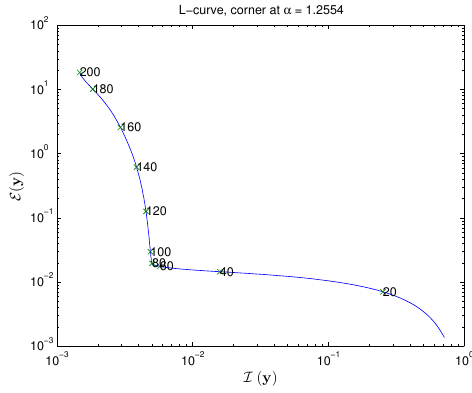
Figure 2. L-curve corresponding to the minimization of J α ( y ) with determination of all the coefficients (constant, linear and quadratic) for the cylinder wake configuration presented in Section